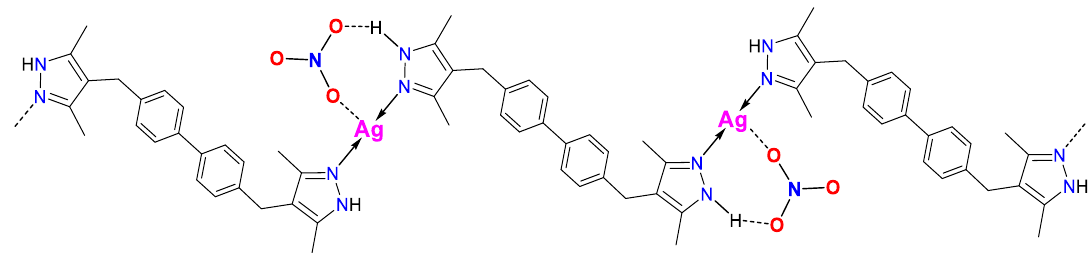
Figure 4. Proposed polymeric structure of [Ag(H 2 DMPMB)(NO 3 )] ( 1 ), evidencing the T-shaped stereochemistry of silver(I) ions assured by the nitrate anions and the neutral ligands coordinated in a bridging exo-bidentate mode.